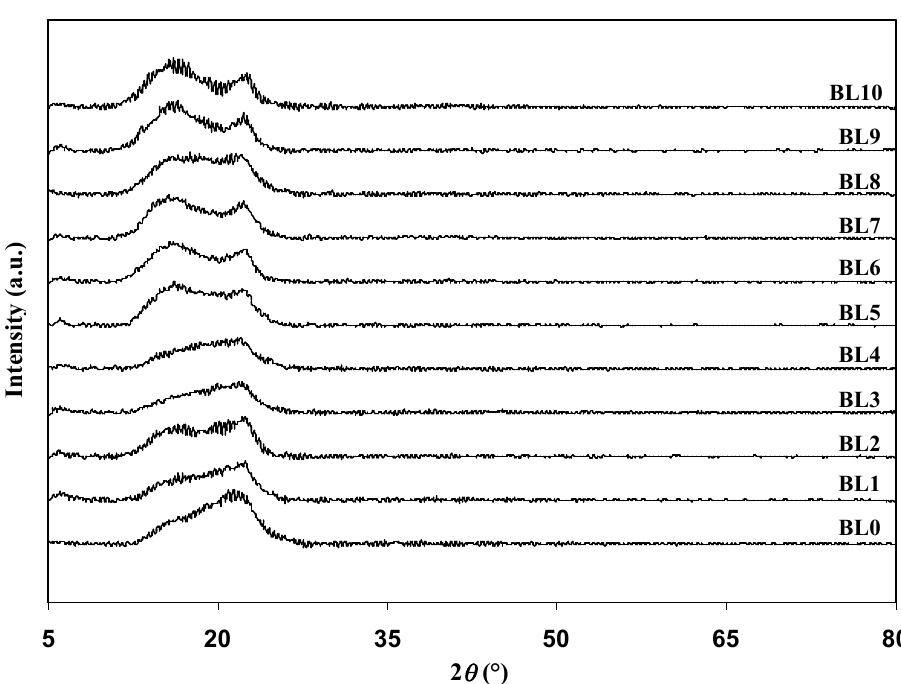
Figure 1. XRD patterns for the polymer blend.